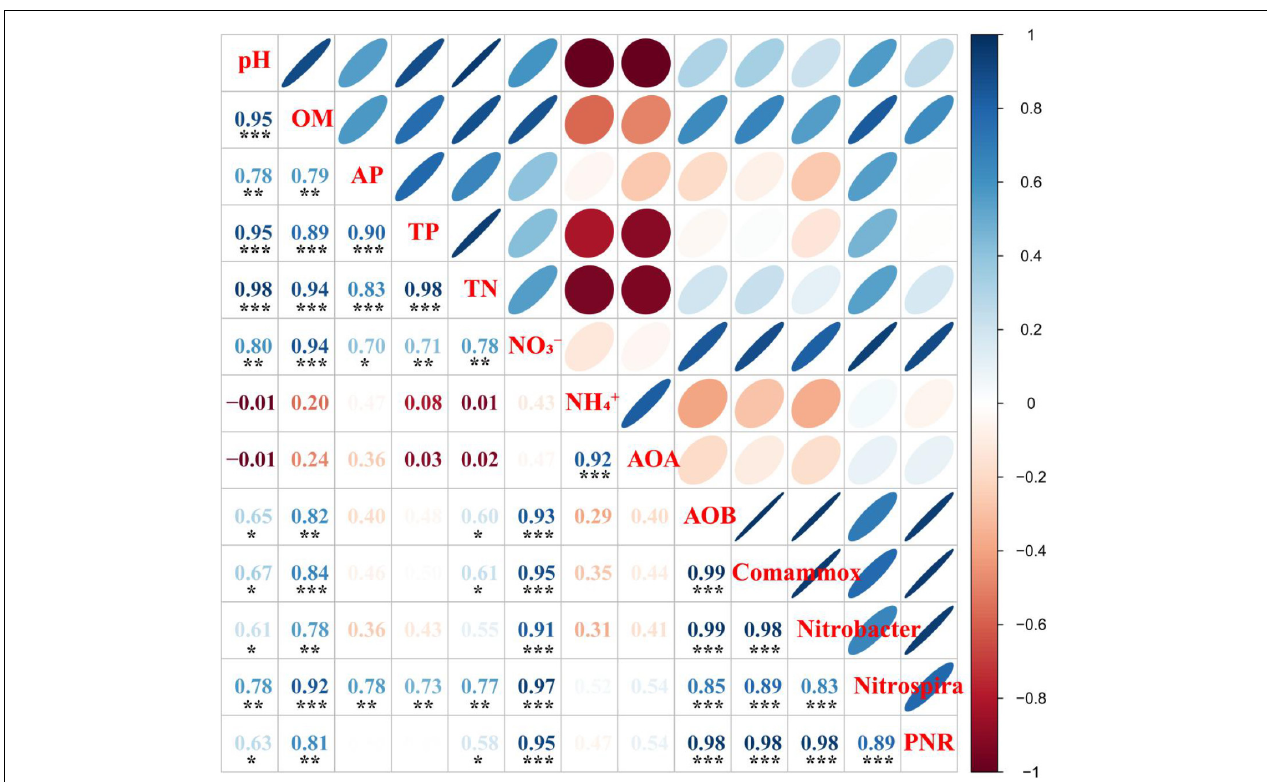
FIGURE 3 | Pearson correlation analyses of soil chemical properties and potential nitrification rate (PNR), and nitrifying community abundances in rhizosphere soil. Blue denotes the significance level p < 0.05, the smaller shapes and darker color denote the larger correlation coefficients; red denotes the significance level p > 0.05, the larger shapes and darker color denote the smaller correlation coefficients. The correlation coefficients are shown in the lower left panel, * indicates p < 0.05, ** indicates p < 0.01, and *** indicates p < 0.001. OM, soil organic matter; AP, available P; TP, total P; TN, total N; NO 3 − , nitrate-N; NH 4 + ,